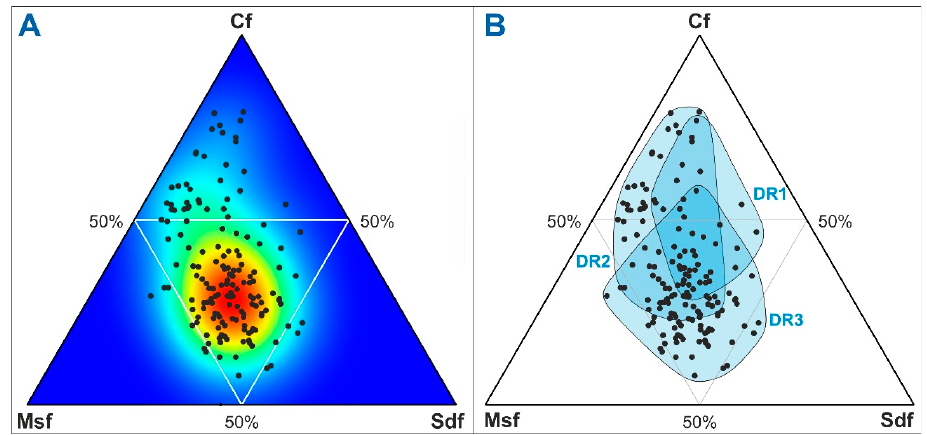
Figure 8. Ternary diagram using the three main forest types (Cf, conifer forest; Msf, Mediterranean sclerophyll forest; Sdf, submontane deciduous forest). Black dots are sample values. ( A ) Density plot. Colors indicate the density of sample points, from higher (red) to lower (blue). ( B ) Sample groups according to DR cycles.